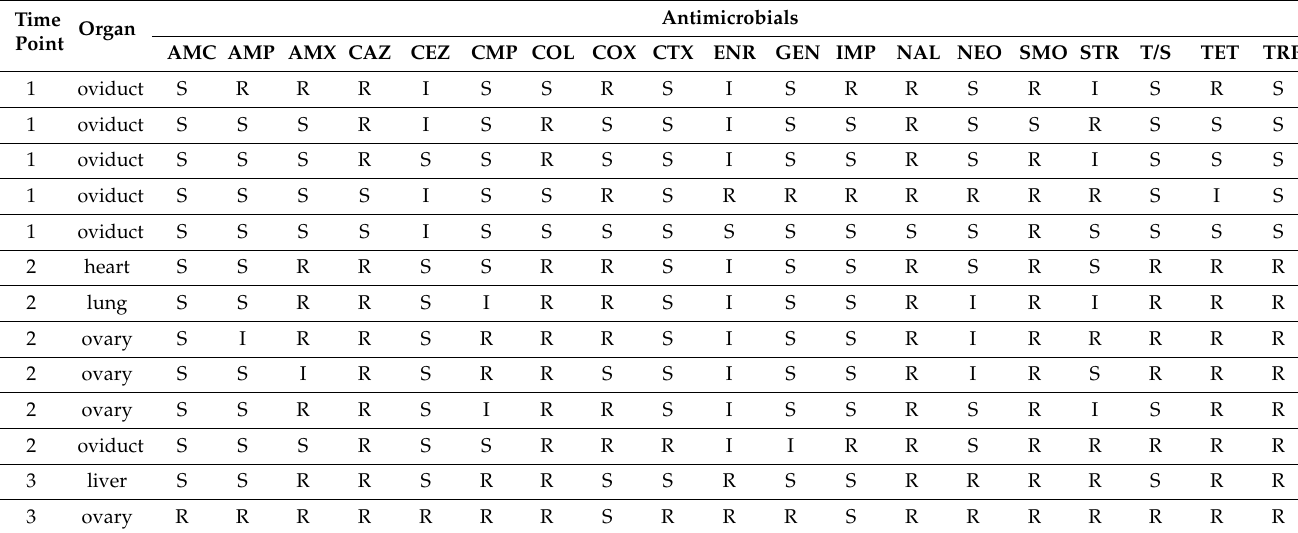
Table 4. Differences in antimicrobial profiles of E. coli isolates within a flock, between organs of the same bird, and within the same organ, exemplarily shown for flock 6 (excluding oxacillin and tylosin). Results of susceptibility testing are given as susceptible (S), resistant (R), and intermediate